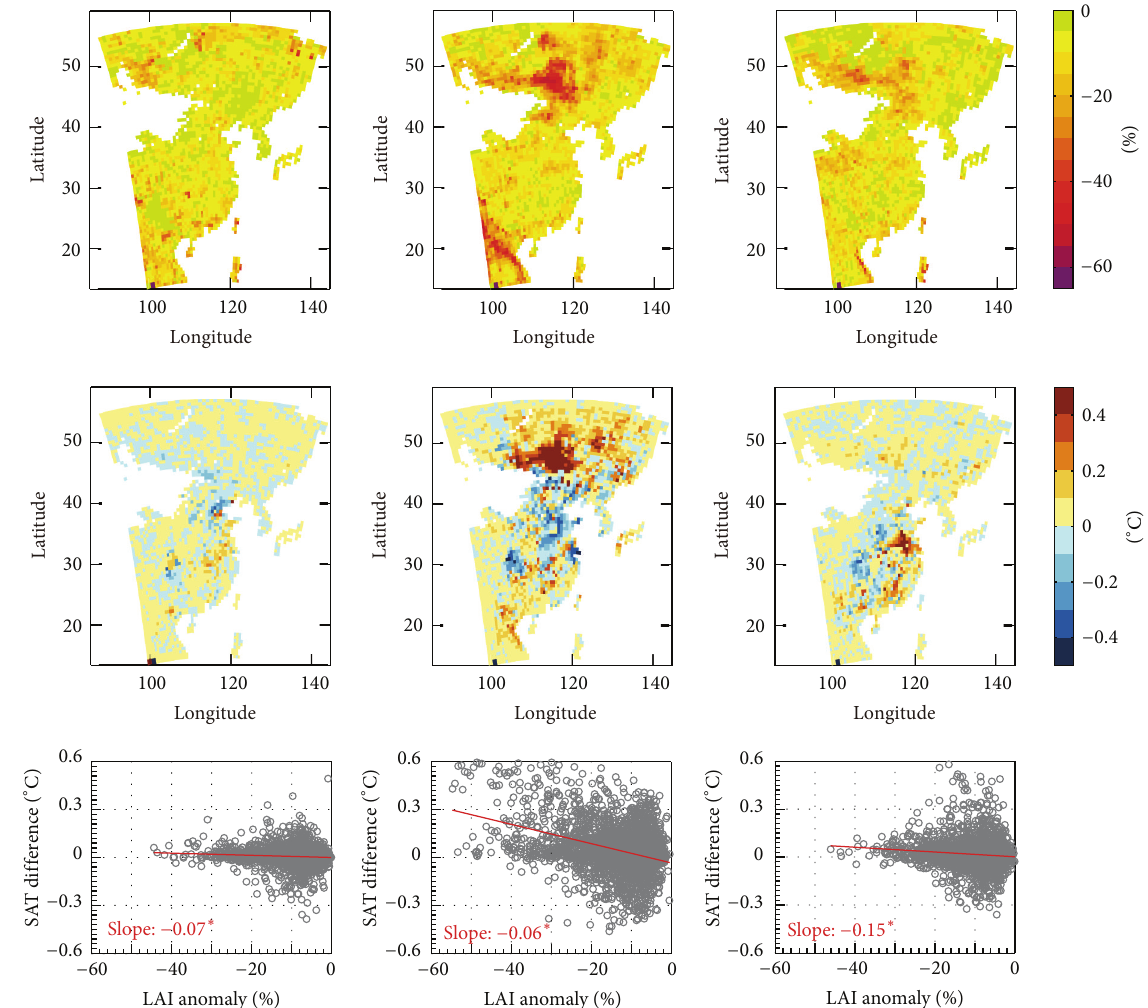
Figure 6: The minimum (negative) anomalies of LAI from 2002 to 2009 (top panel), the differences of simulated surface air temperature (SAT) by DYC and FIX (DYC minus FIX; middle panel), and the grid cell-based spatial correlations between the LAI anomalies and SAT differences (bottom panel; the red straight line is the best fitting line and the slope as unit of 0.01 ∘ C per 1% LAI; the stars represent the confidence level higher than 99.9%) for spring (left panel), summer (middle panel), and autumn (right panel).